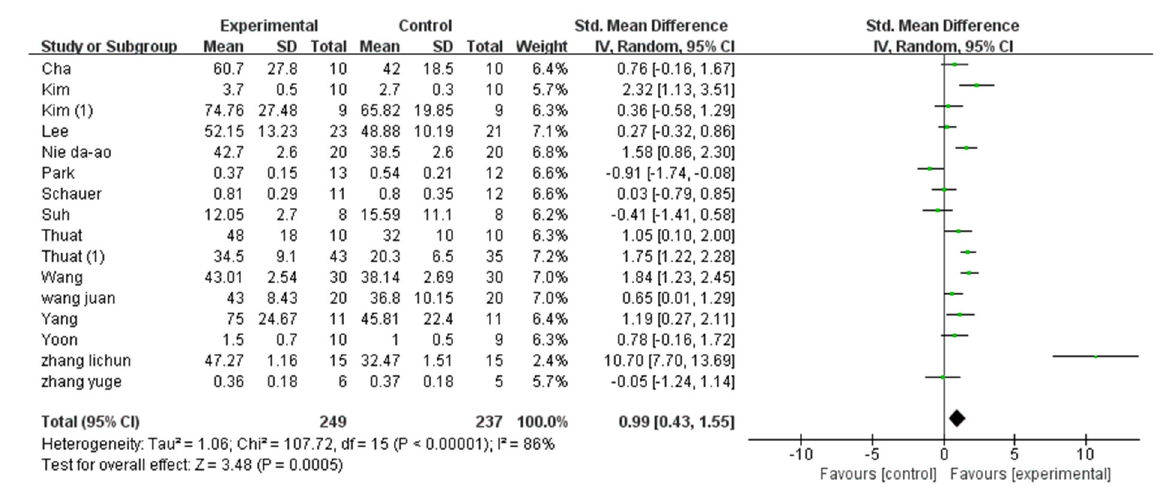
FIGURE6 Forest plot of velocity for meta-analysis.